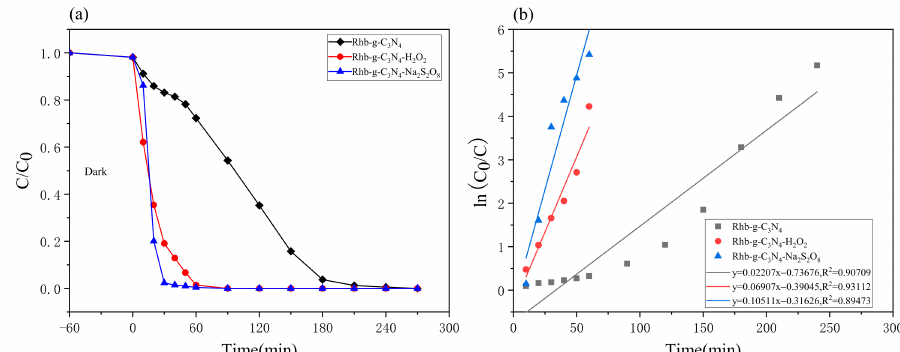
Figure 3. Rhb photocatalytic performance curves of different systems (photocatalyst dosage = 0.1 g, target pollutant = 50 mg/L): ( a ) photocatalytic activity of Rhb degradation photocatalyst under visible light irradiation; ( b ) the first-order kinetic curve of Rhb degradation photocatalyst under visible light irradiation.